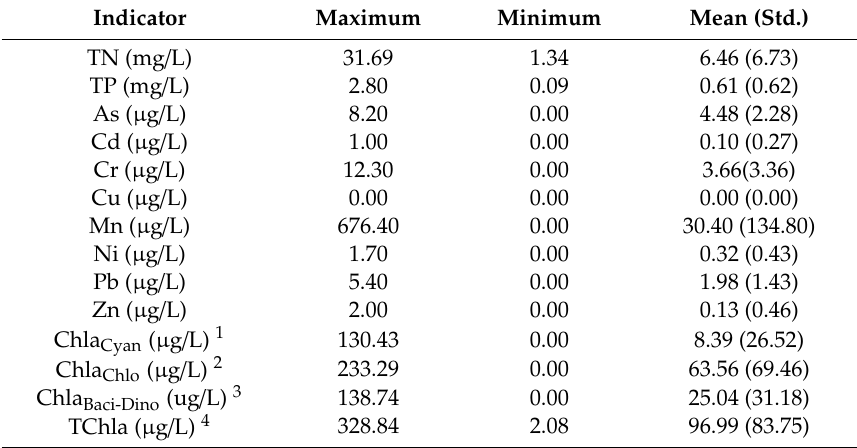
Table 3. Statistics of the stream water quality parameters. TN: total nitrogen and TP: total phosphorus.